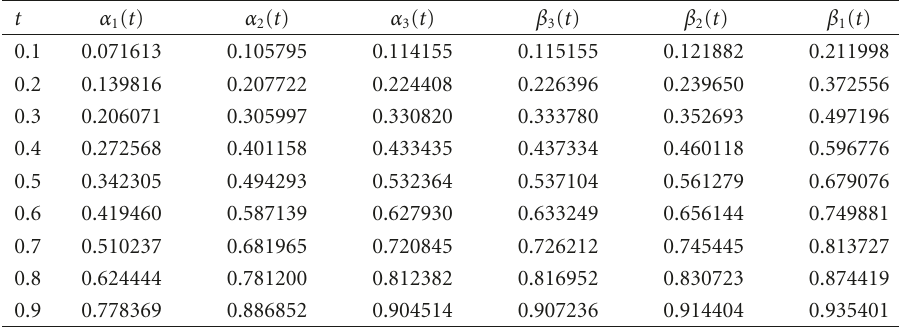
Table 4.1. Table of three α , β -iterates of